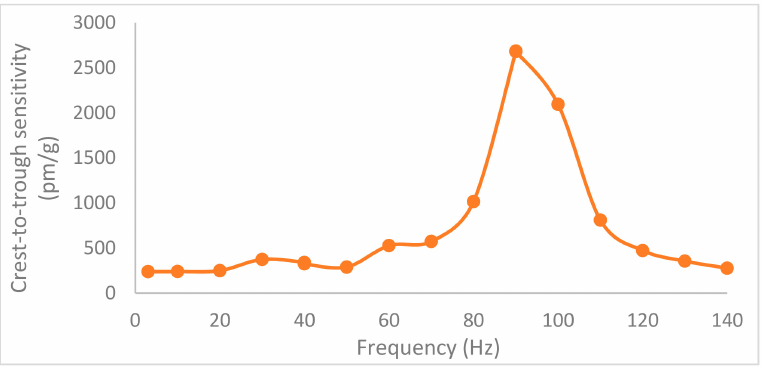
Figure 5. Frequency